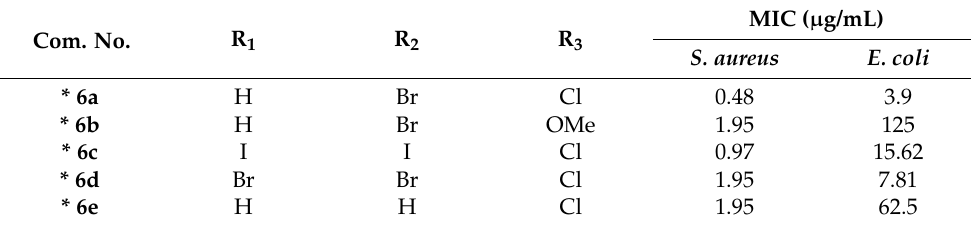
Table 12. Antibacterial activities of novel sulfur-containing tricyclic flavonoids ( 6a – h ) against S. aureus and E. coli .